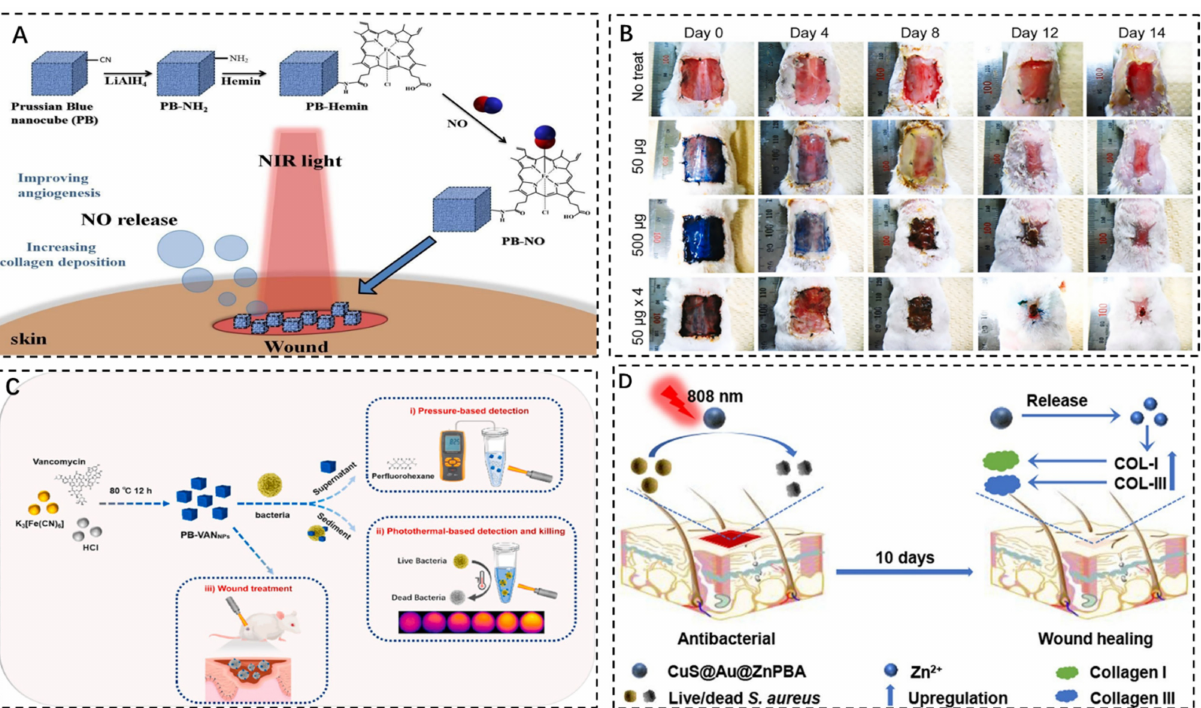
Figure 7. ( A ): PB nanocubes deliver NO to the wound site under NIR light [78]. ( B ): Observation of the effect of PBzyme in different groups on wound healing at different time [63]. ( C ): Schematic diagram of preparation, discovery, and removal of PB bacteria − VANNPs [42]. ( D ): CuS@Au@ZnPBA for photothermal sterilization and accelerated incision healing [79]. Copyright application has been